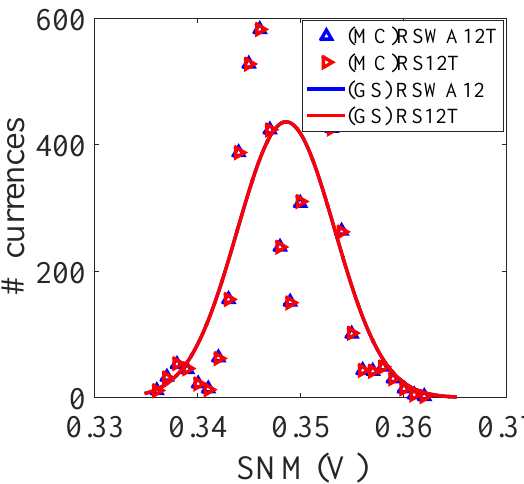
Figure 22. Process variation analysis of SNM for proposed SRAM cell.